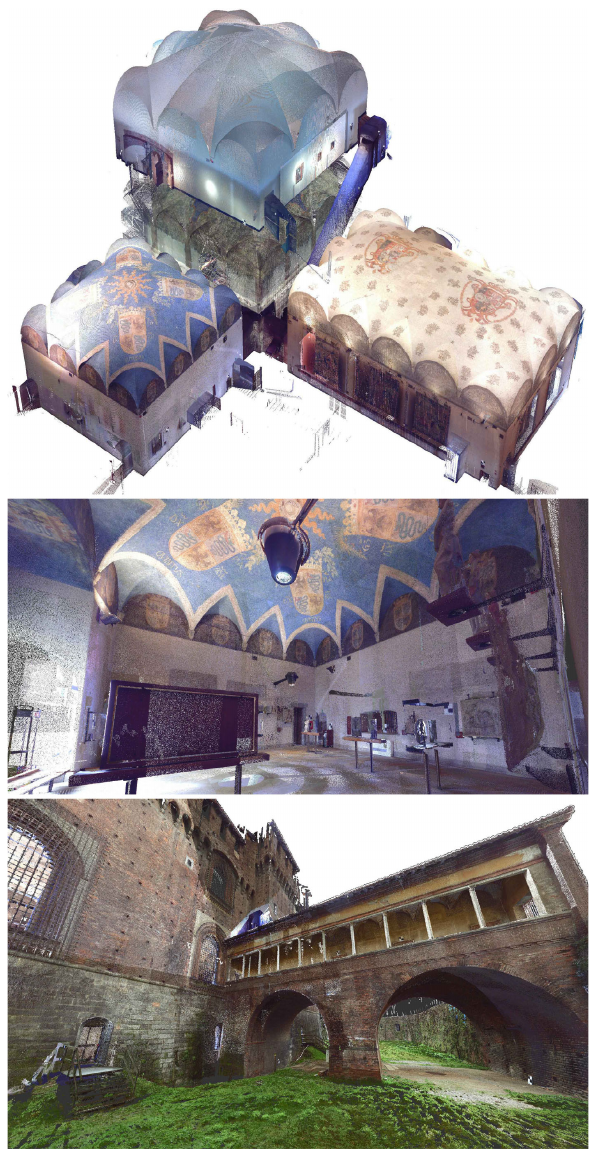
Figure 4. Different views of the colored final point cloud detail and the color of the points with their intensity (black and white or real